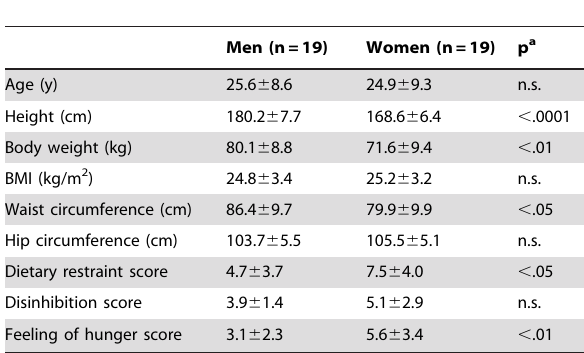
Table 1. Characteristics of men and